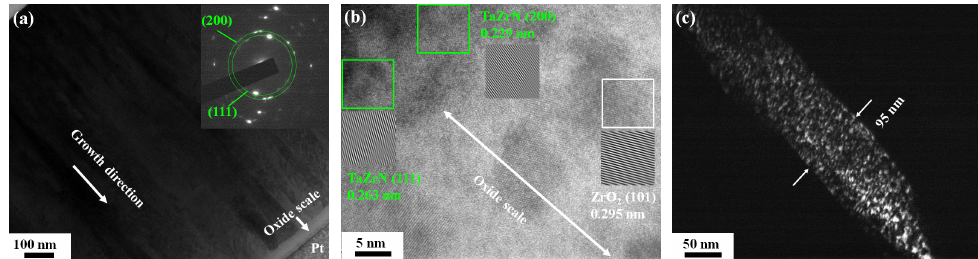
Figure 7. ( a ) Cross ‐ sectional TEM image of the Ta 0.58 Zr 0.42 N 0.59 thin film after annealing at 600 °C in 15 ppm O 2 ‐ N 2 for 8 h; ( b ) high ‐ resolution image of the outermost surface region; and ( c ) dark ‐ field image corresponding to the (111) diffraction spot.